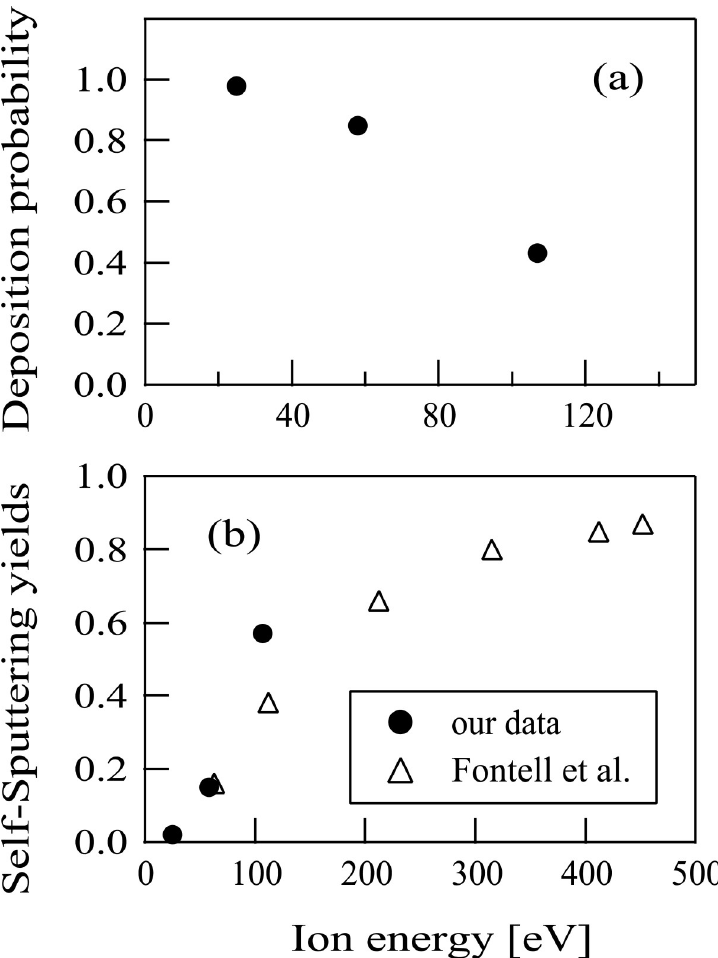
Fig 8. The measured deposition probabilities of Sn + ions versus the ion injection energy are shown by closed circles in the figure (a). The self-sputtering yields of Sn are plotted by closed circles in the figure (b). In the figure (b), previous data presented by Fontell et al . [42] are also shown by open triangles for